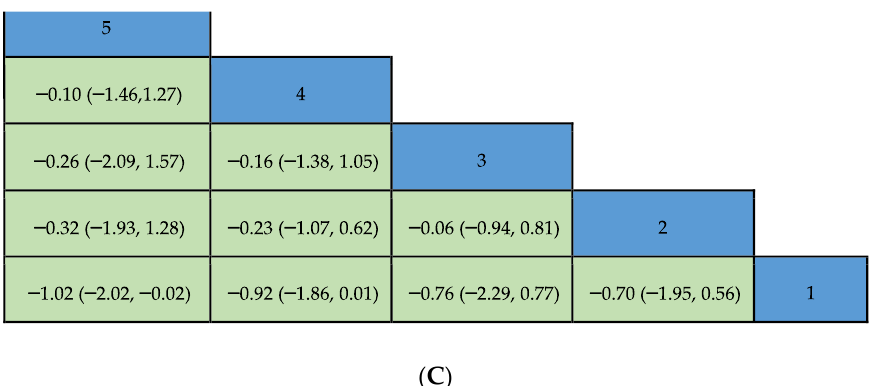
Figure 5. ( A ) NMA figure for 20 m sprint; ( B ) SUCRA plot for 20 m sprint; ( C ) league table of 20 m sprint. 1 = control group; 2 = resistance training group; 3 = resisted sprint + agility training group; 4 = plyometric + resistance + sprint + agility training group; 5 = plyometric + sprint + agility training group.